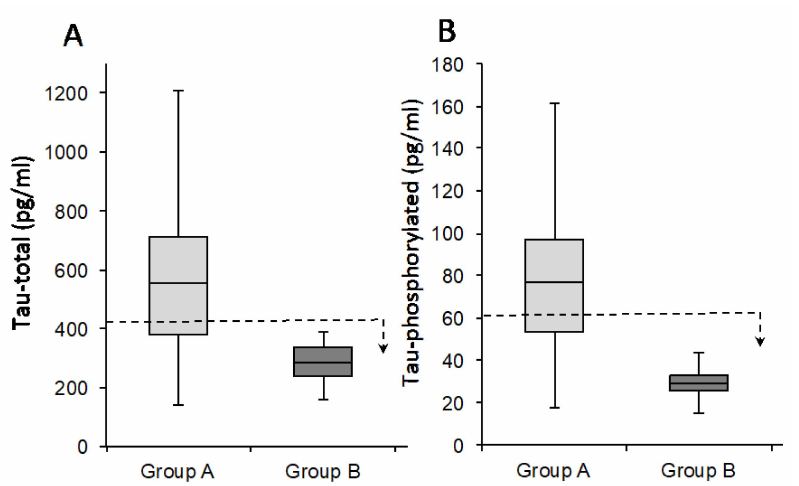
Figure 2. Subdivision of patients into two groups regarding the expression of Tau-total ( A ) and Tau-phosphorylated ( B ). The dotted line represents the threshold for a subject to be considered AD or normal; the arrow indicates the direction of values for which the subjects are not affected by AD. All groups were evaluated for significance according to Student’s t -test ( p < 0.01). Group A is depicted in light gray, and Group B is depicted in dark